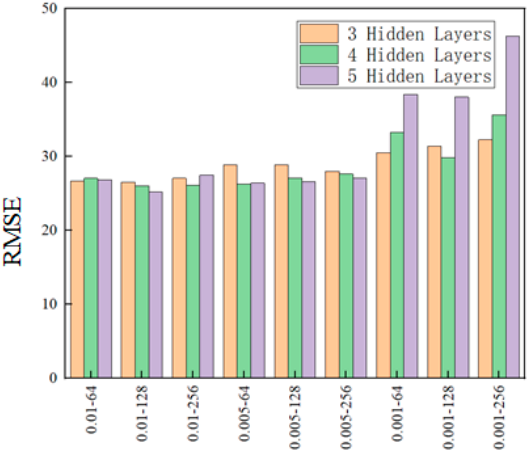
Figure 6. Influence of hidden layer on RMSE.